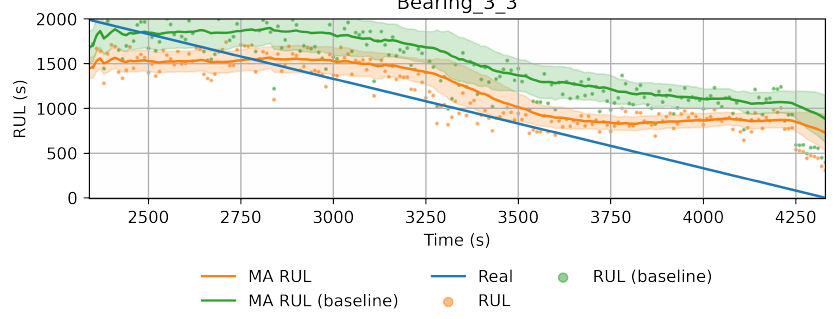
Figure 18. RUL estimation for bearing 3_3. Comparing the benchmark (green) and the proposed method. Intervals as the +/ − 1 running standard deviation.